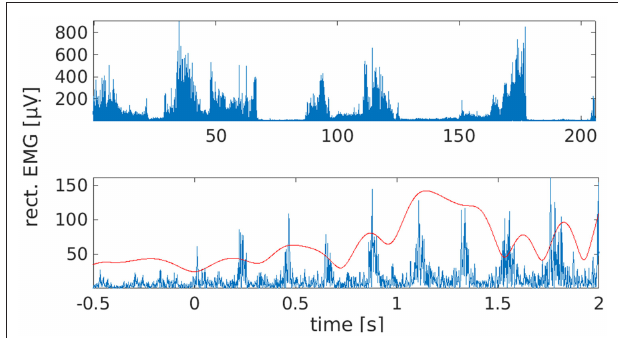
FIGURE 1 | Waxing and waning of leg tremor. (Top) Rectified EMG trace from right lower leg. Note the presence of transient tremor arrests/reductions. These were induced by the patient by repositioning the feet. (Bottom) Example of a tremor onset episode. Time 0 marks the time of tremor onset, as estimated by inspection of the right leg EMG trace (blue) and EMG power between 3 and 8Hz (red).